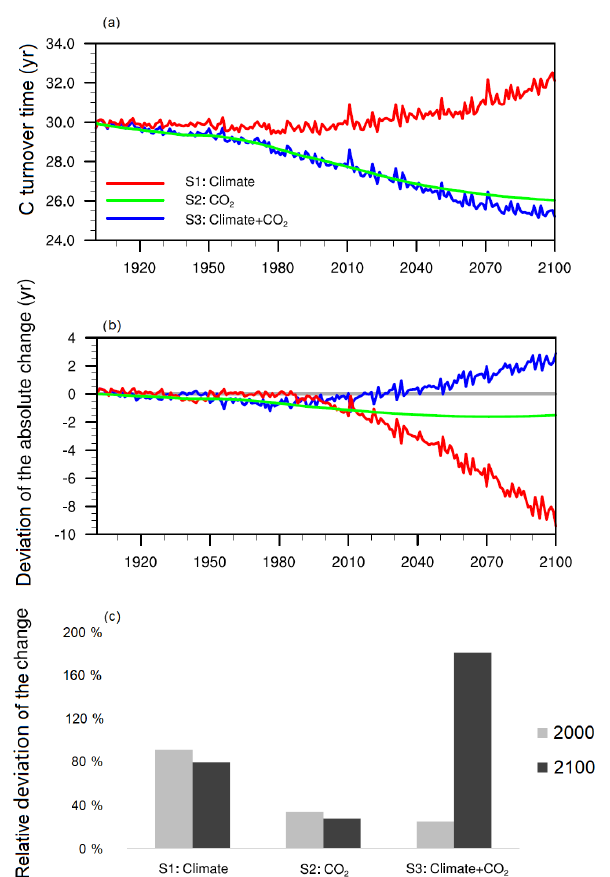
Figure 5. (a) Changes of global C turnover time (stock over flux) in S1: climate warming scenario (red line), S2: rising atmospheric [CO 2 ] scenario (green line), and S3: combined climate warming and rising atmospheric [CO 2 ] scenario (blue line). (b) The deviation of the change in C turnover time ( (cid:49)τ to ) is estimated relative to the change in C transit time ( (cid:49)τ ts ): ( | (cid:49)τ to |−| (cid:49)τ ts | ) . Positive indicates more change in C turnover time than C transit time. The grey line represents the reference of no deviation. (c) The relative deviation of the change in C turnover time in the years 2000 and 2100 is also estimated relative to the change in C transit time: (